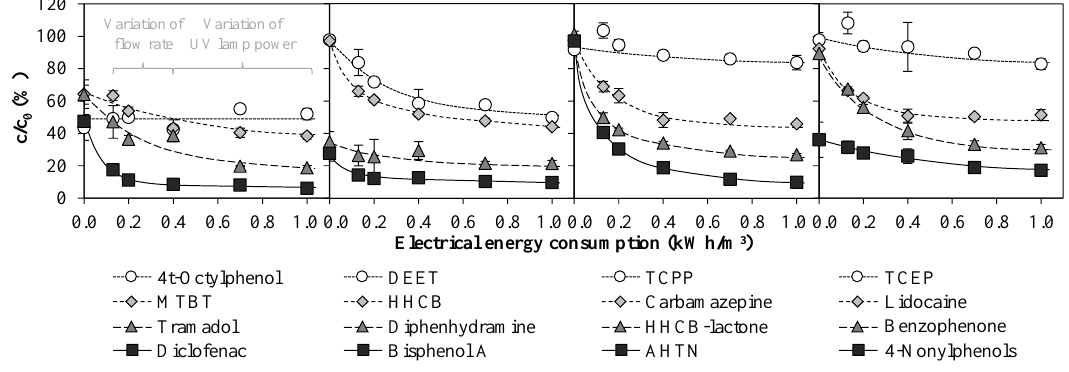
Figure 10. Emerging contaminants after treatment of WWTE by means of an AOP pilot plant as a function of the electrical energy consumption at 3 mg/L FAC in the UV chamber influent and subsequent quenching with H 2 O 2 . The results of two experiments are shown: variation of flow rate between 1 and 3 m 3 /h at 0.4 kW UV lamp power (Exp. D) and variation of UV lamp power between 0 and 1 kW at a flow rate of 1 m 3 /h (taken from Rott et al. [7]). For E EO values, see Table S8.